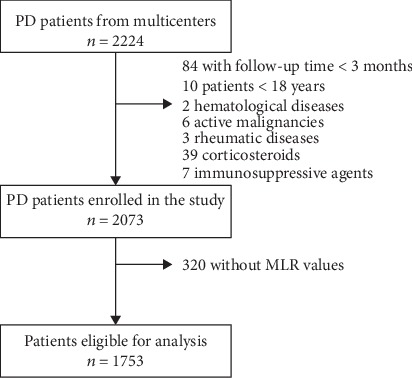
The flow chart shows how patients were selected for the present study. PD: peritoneal dialysis; MLR: monocyte-to-lymphocyte ratio.